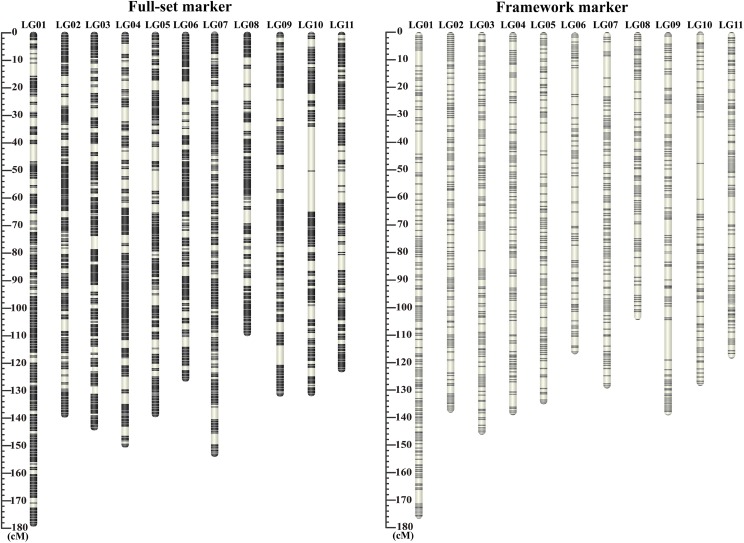
Distribution of full-set and framework markers along the P. orientalis 11 linkage groups. The full-set markers map (left) is composed of 23,926 loci with a total length of 1,506 cM. The framework markers map (right) is composed of 7,559 loci with an average spacing of 0.2 cM and a total length of 1,443 cM. In each linkage group, the black horizontal bars show the positions of the markers. The thickness of bar is proportional to the number of co-segregation markers in the same position.